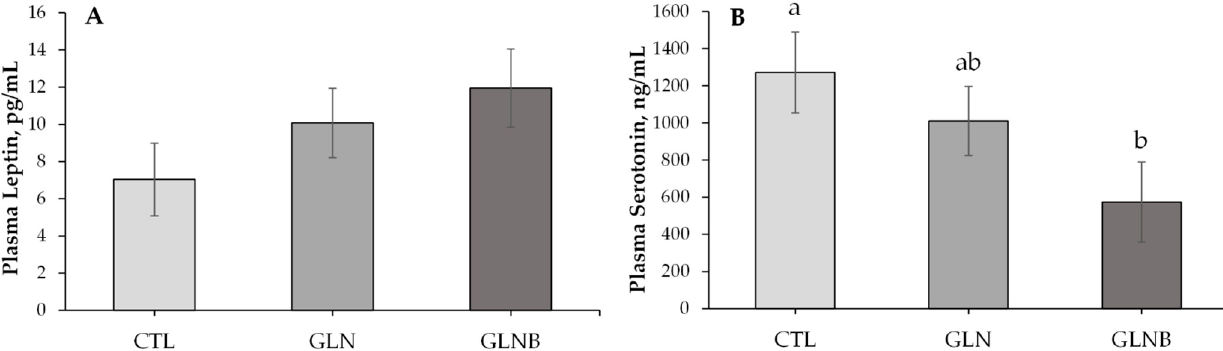
Figure 2. Plasma leptin ( A ) and serotonin ( B ) concentrations of weaning calves (n = 11) on the last day (42 d of age) of supplementing Gln (GLN) or Gln with BCAA (GLNB) compared to weaning without an AA supplementation (CTL). a,b Least squares means with different superscripts indicate significant difference ( p < 0.05).